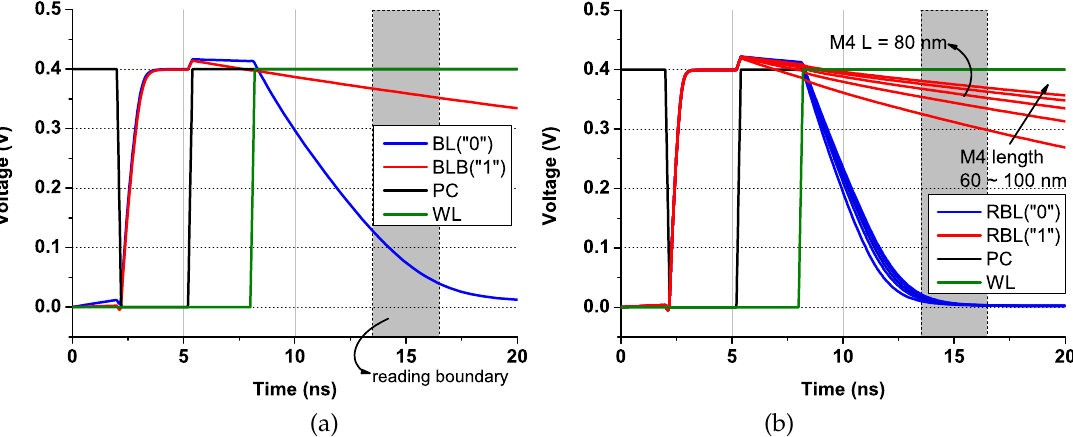
Figure 7. Waveform of read operation in ( a ) 6T and ( b ) 8T.